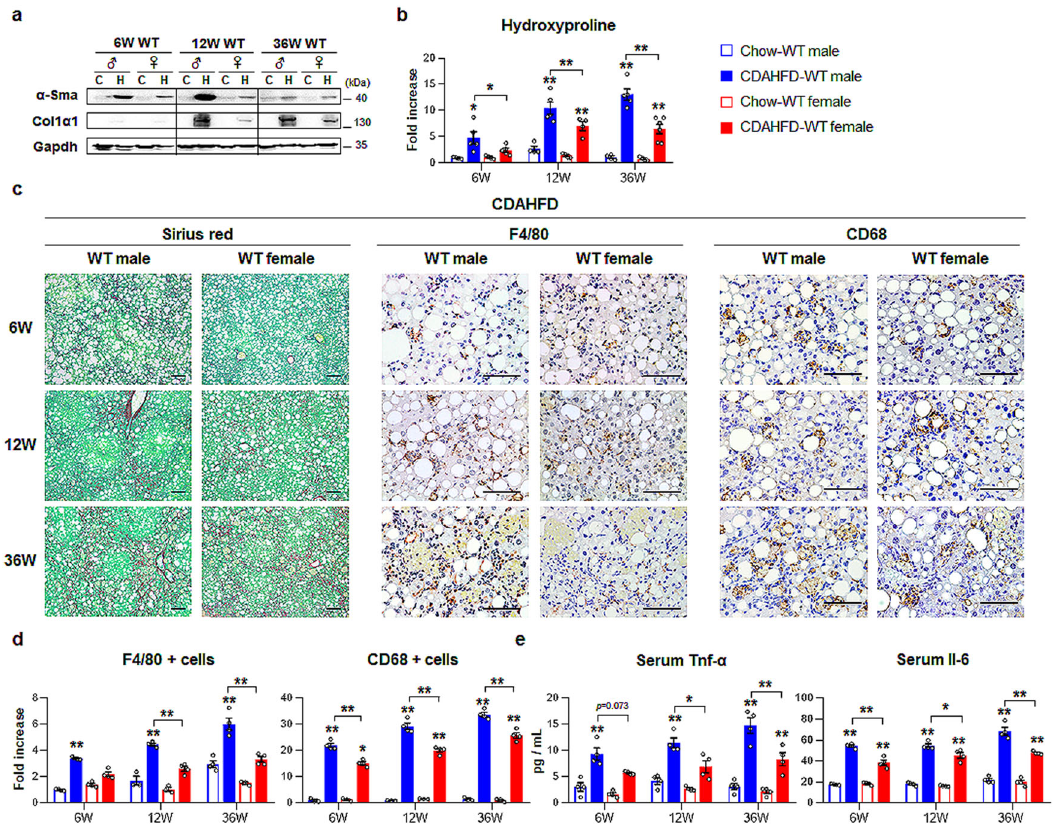
Fig. 2 Enhanced liver fi brosis and in fl ammation in CDAHFD-fed male than female. a Western blot analysis of hepatic alpha-smooth muscle actin ( α - Sma) and collagen 1 alpha 1 (Col1 α 1) in wild-type (WT) male and female mice treated with chow or choline-de fi cient, L-amino acid-de fi ned, high-fat diet (CDAHFD). Each lane contains protein lysates pooled from representative three mice per group with equal concentration. Glyceraldehyde 3-phosphate dehydrogenase (Gapdh) was used as internal control. The data shown represent one of three experiments with similar results. b Hepatic hydroxyproline content in liver tissues from representative mice per each group. Data represent the mean ± S.E.M. ( n ≥ 4/group, * p < 0.05, ** p < 0.005 vs own control). c Representative images of Sirius red- (left panel) and F4/80- (middle panel) and CD68-stained (right panel) liver sections from the CDAHFD-WT groups (Scale bar, 50 μ m). d Quantitative F4/80- or CD68-stained data from these WT mice. F4/80- or CD68-positive Kupffer cells were quanti fi ed by dividing the total numbers of positive cells by the total number of Kupffer cells. Data represent the mean ± S.E.M. ( n ≥ 4/group, * p < 0.05, ** p < 0.005 vs own control). e Levels of serum Tnf- α and Il-6 in representative mice from each group. Data represent the mean ± S.E.M. ( n ≥ 4/group, * p < 0.05, ** p < 0.005 vs own control). Gray circles represent individual data points. See Supplementary Data for statistical